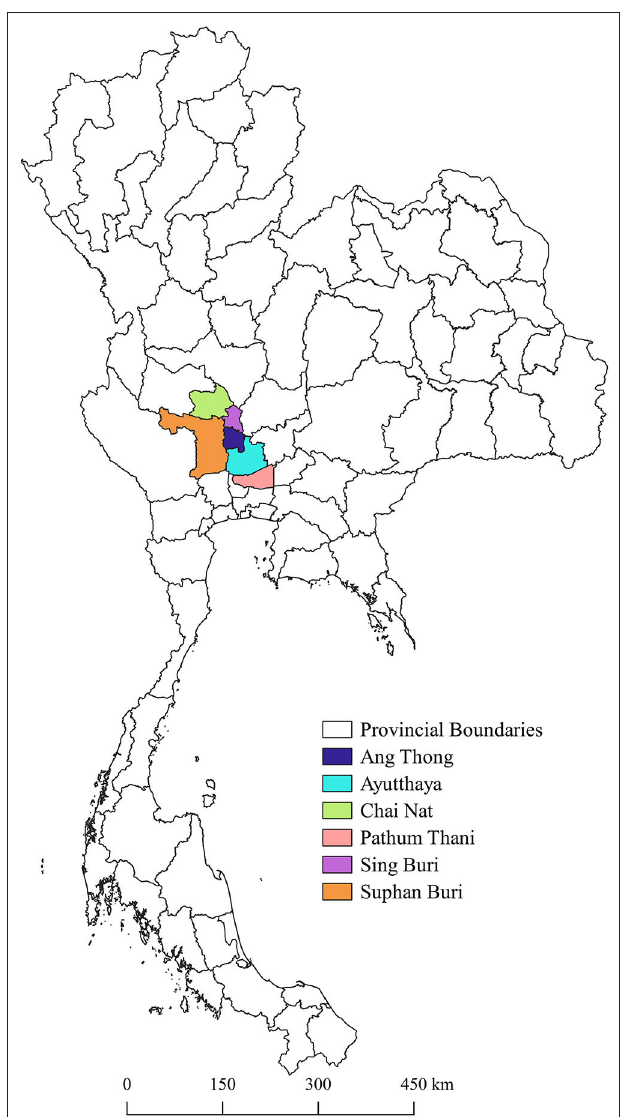
FIGURE 1 | Location of target provinces as the study